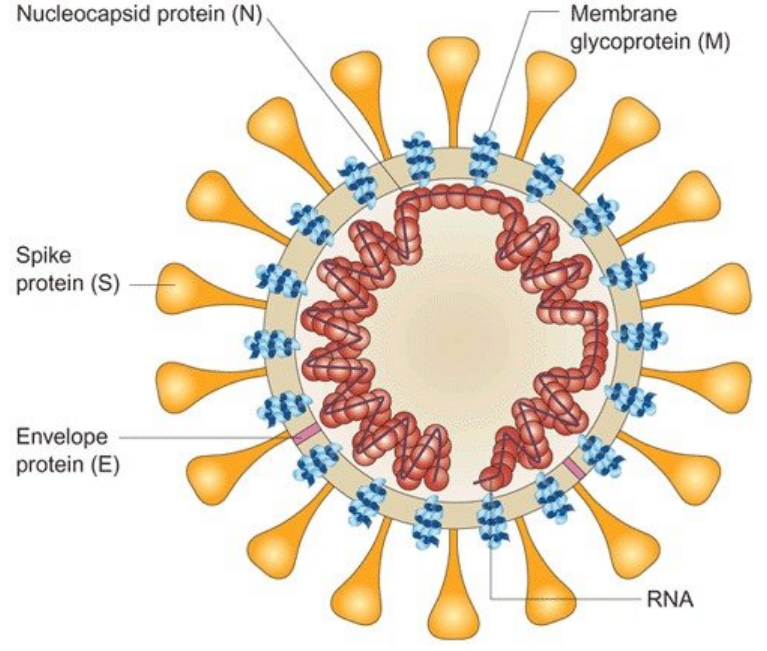
Figure 1. General structure of SARS-CoV [19].